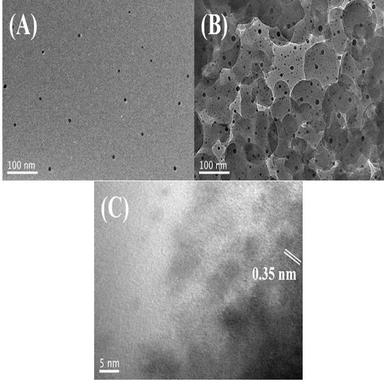
TEM and HRTEM images of ERGQDs (A) and ERGQDs/PPy-2 (B, C).